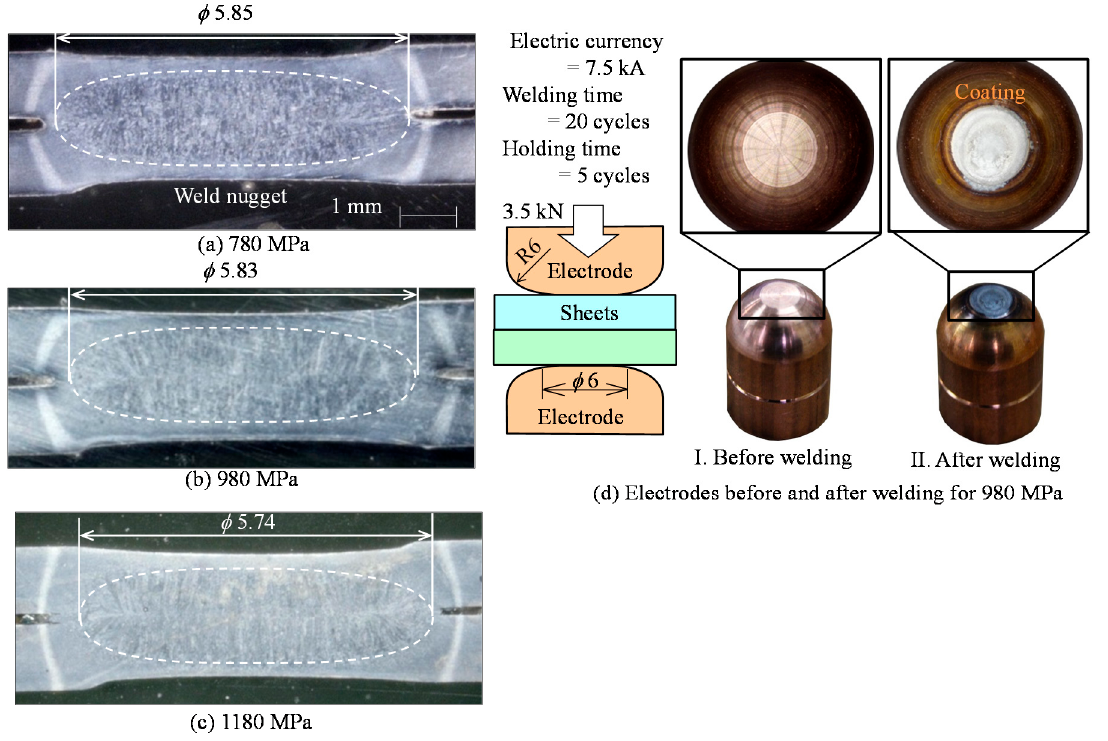
Figure 3. Conditions of resistance spot welding and welded sheets.